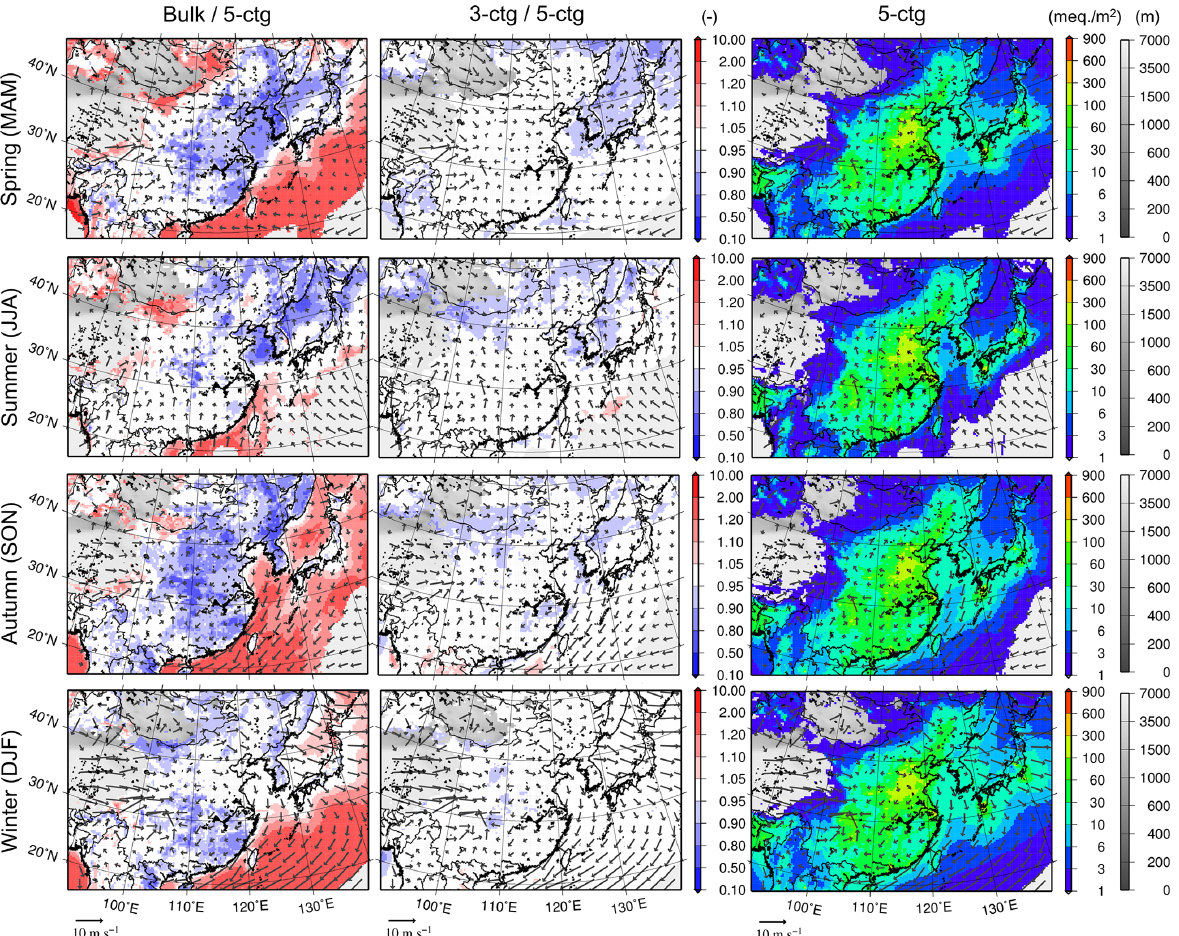
Figure 6. Same as Figs. 3–5 but for the dry deposition of sum of nss-SO 2 −